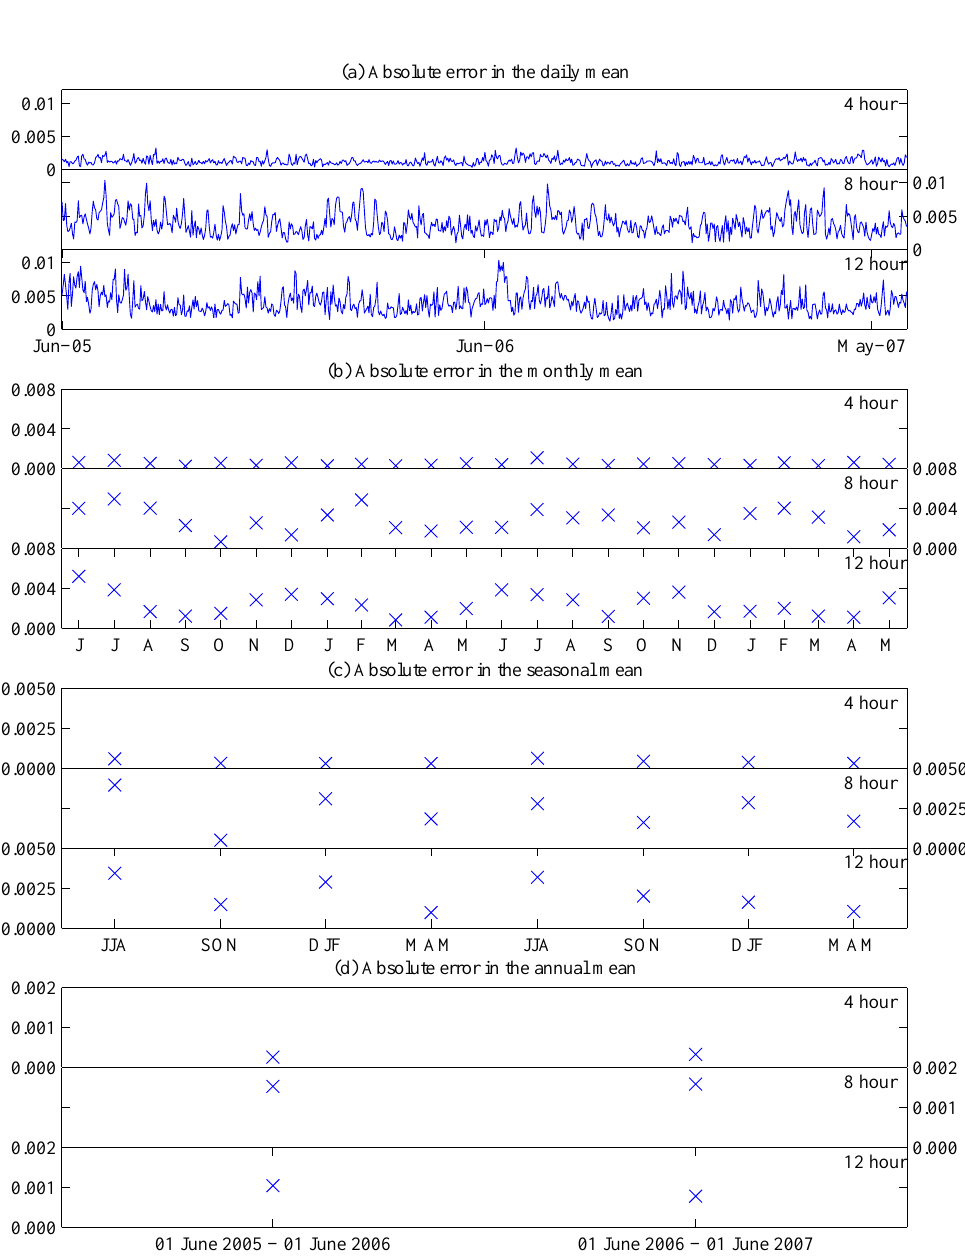
Figure 6. All panels ( a – d ) as for Figure 4 but for the sunlit ocean.